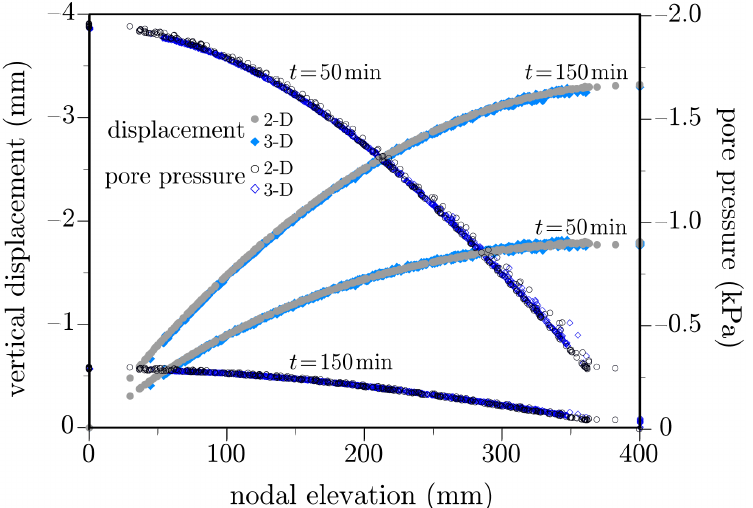
Figure 14. Nodal values of vertical displacement and pore pressure at differing times after